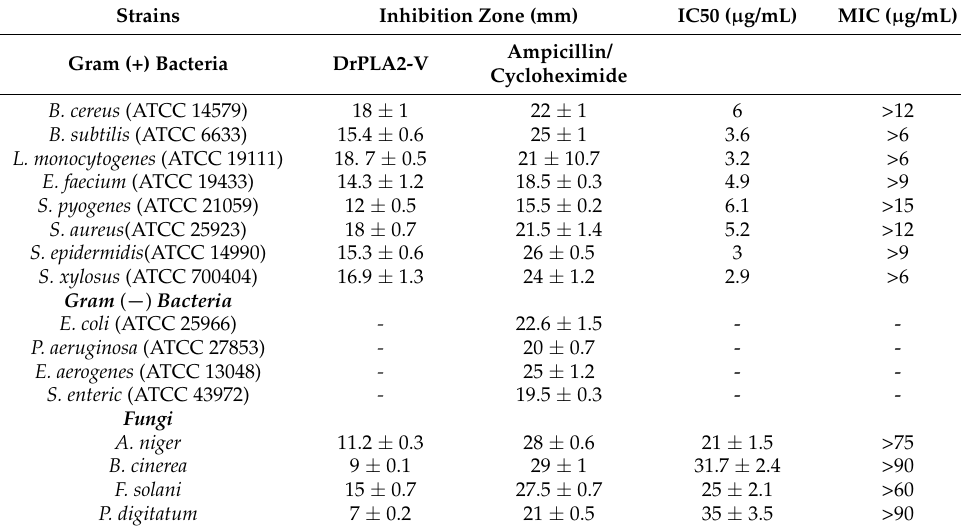
Table 3. Antimicrobial activity of DrPLA 2 -V on bacterial and fungal